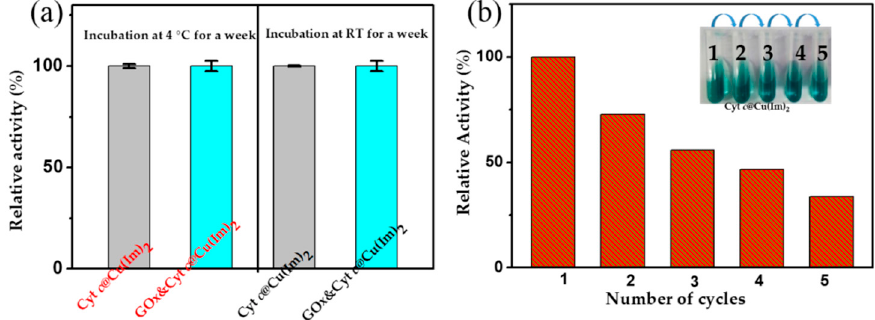
Figure 6. ( a ) Stability for Cyt c @Cu(Im) 2 and GOx-Cyt c @Cu(Im) 2 against long-term placing; ( b ) Reusability of Cyt c @Cu(Im) 2 .